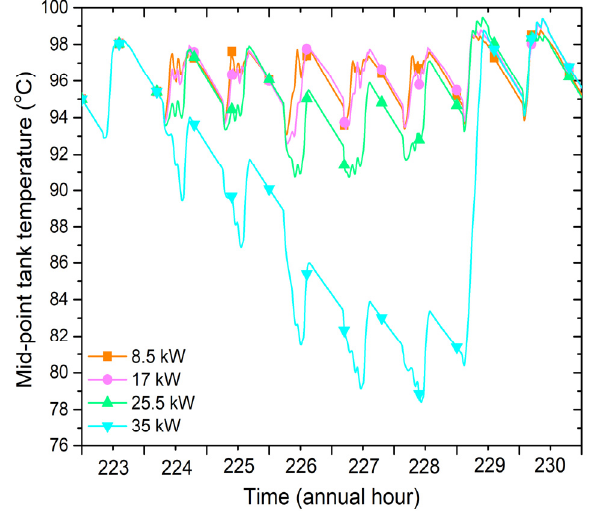
Figure 7. Thermal energy storage tank (TEST) temperature when varying the thermal load.